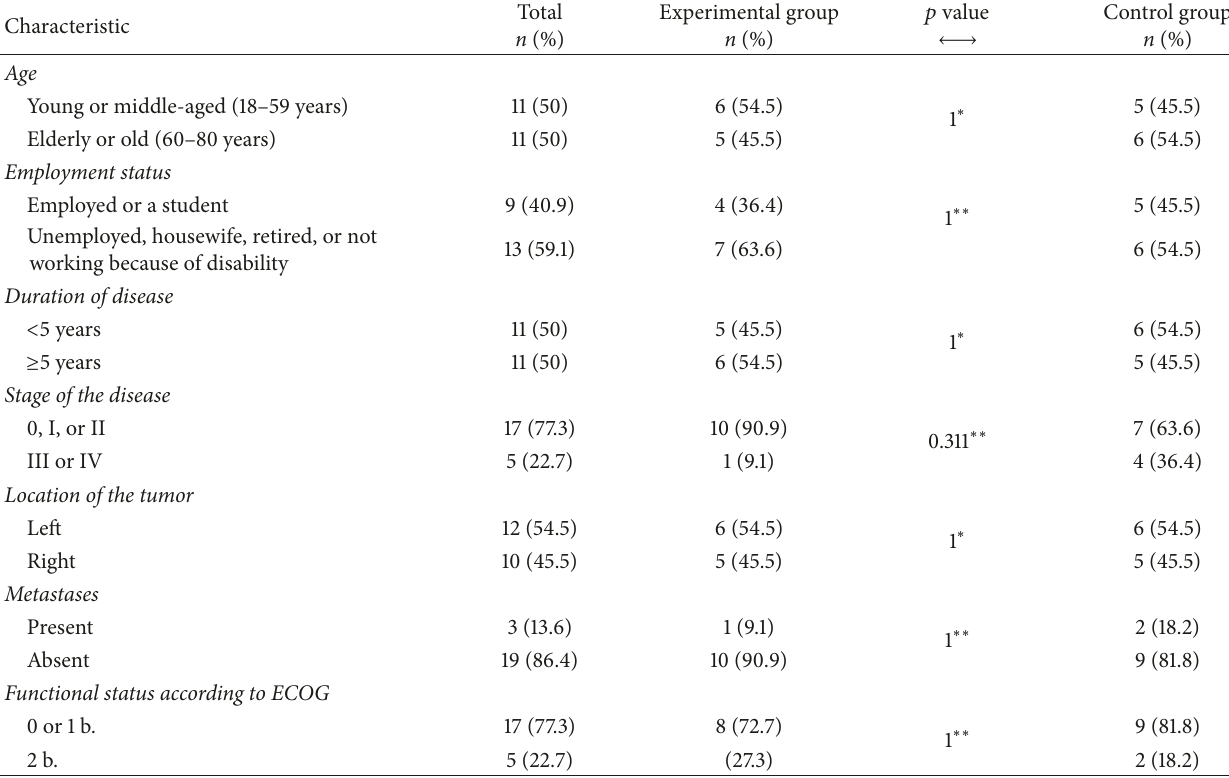
Table 1: Participants’